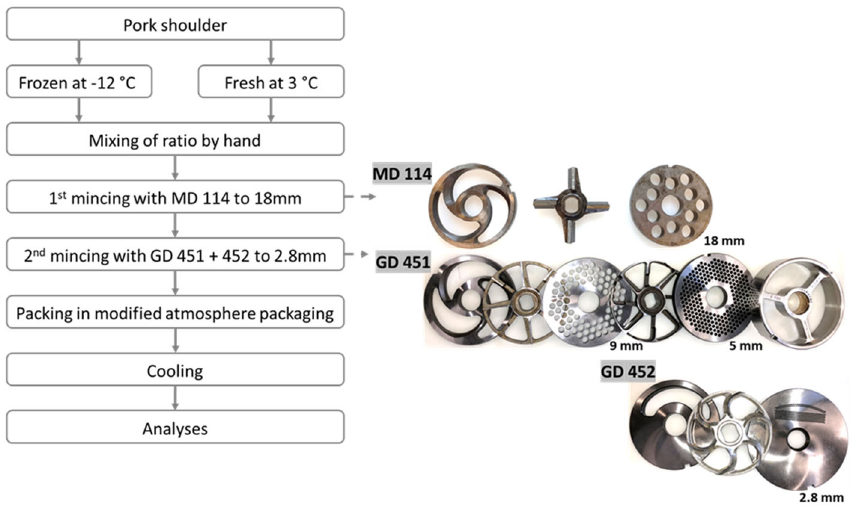
Figure 1. Flow chart of the minced pork production process with photographs of the grinding systems used.